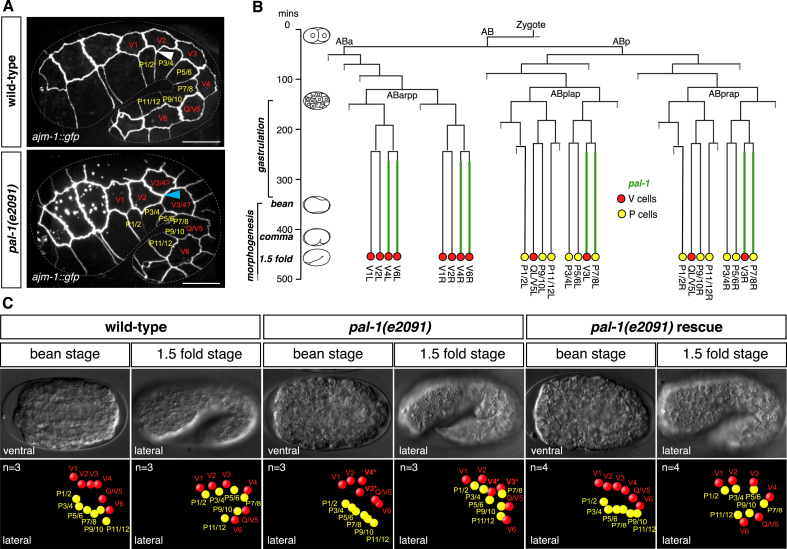
pal-1 is required for seam organisation in the embryo.A. Maximum intensity projections of lateral z stacks of wild-type and pal-1(e2091) 1.5 fold embryos carrying the ajm-1::gfp apical junction marker (strain AW298). The V lineage seam cells and the P cells are labelled. In wild-type embryos, the seam cells are ordered end to end along the a-p axis, and the apical junction between the ventral P cells lies towards the anterior of the ventral edge of each seam cell (example shown by the white arrowhead). In pal-1(e2091) animals the V3 and V4 seam cells are misaligned and partially share a-p coordinates. Misalignment of V3 and V4 skews the position of a ventrally joining apical junction such that it lies to the posterior (rather than the wild-type anterior) of the seam cell (blue arrowhead). Scale bar ​= ​10 ​ ​μm. B. Partial embryonic cell lineage of a wild-type embryo (re-drawn using timings from Sulston et al., 1983). Minutes from the first cleavage as well as timings of embryonic stages, gastrulation and morphogenesis are shown on the left. Green lines represent the expression of a rescuing full-length pal-1::gfp construct (n ​= ​4). Dotted lines represent additional unrepresented lineages. C. Embryonic 4D-lineaging of the V seam cells and P cells in wild-type animals (n ​= ​3 lineages), pal-1(e2091) mutants (n ​= ​3 lineages) and pal-1(e2091) carrying a full-length pal-1::gfp transgene (n ​= ​4 lineages) reveals the cell sorting defects of V3 and V4 in pal-1 mutants that are fully rescued by the transgene. For each genotype a representative DIC image and 3D-position of the V and P cells in the embryo are shown for the bean and 1.5 fold stages. Asterisks indicate the cells which are abnormally positioned in the pal-1(e2091) embryo; by bean, V3 has failed to migrate to its proper position in the line of seam cells. Thus, as elongation of the embryo occurs and the animal reaches 1.5 fold, V3 remains to the posterior of V4 (therefore, from position alone, the identity of these cells cannot be determined, see Fig. 1, Fig. 3).